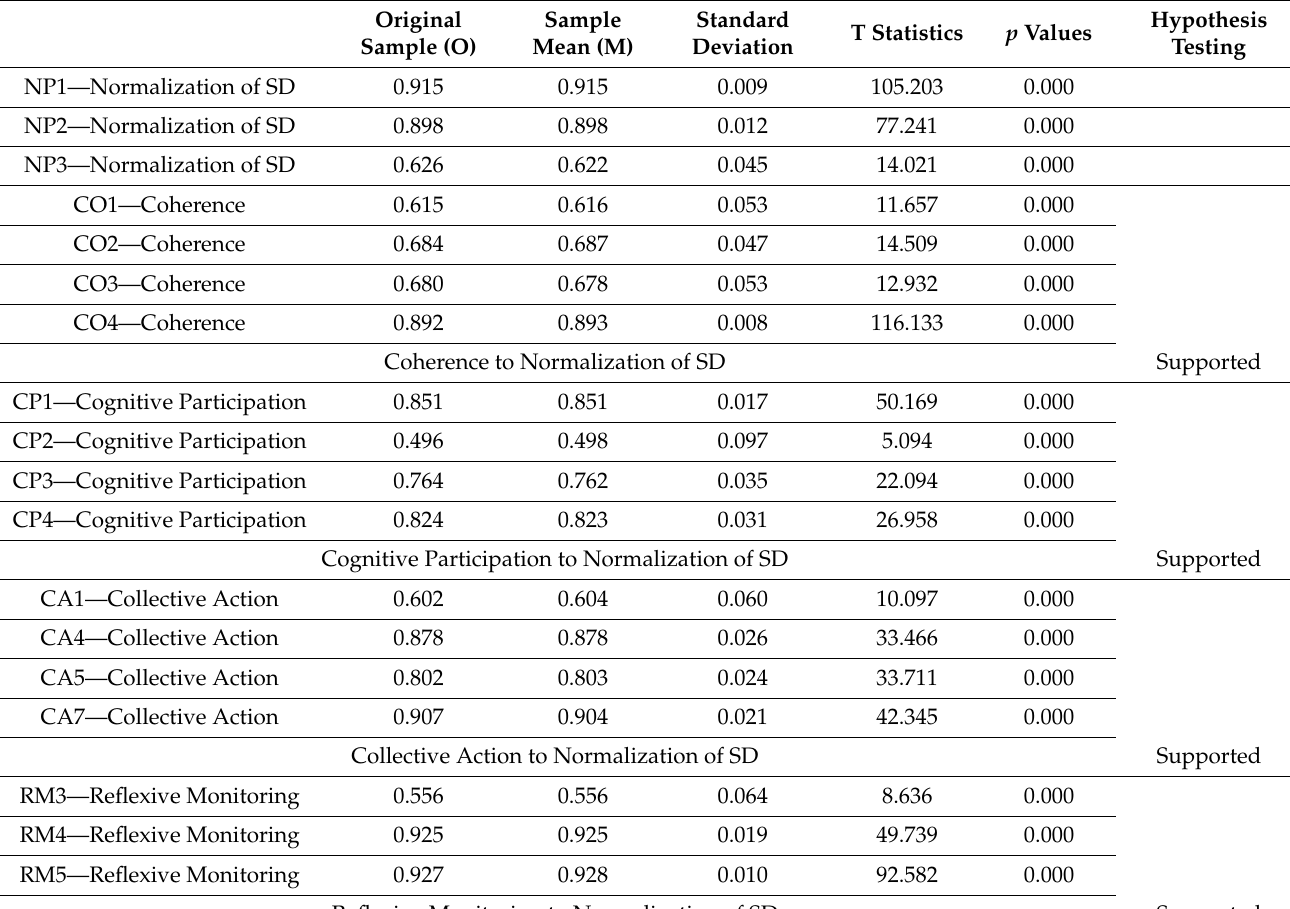
Table 4. Descriptive statistics and hypothesis